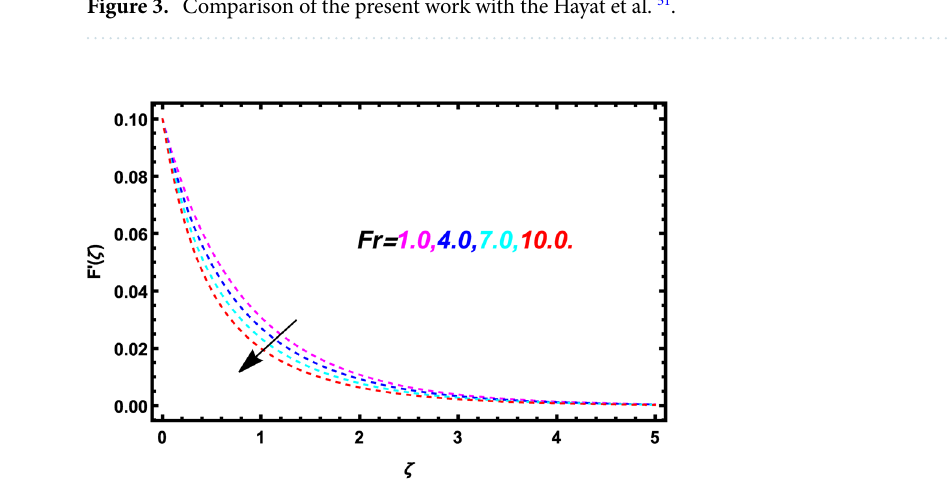
Figure 4. Demonstration of velocity curve versus Fr , when k 1 = 0.1, k 2 = 0.3, M = 0.5, m = 0.2, Pr = 5.3, φ = 0.01, Ec = 0.3, ε Rd = 0.2, Sc = 0.1, ε Lb = 0.3, Pe = t = 3.0, C = 3.0, δ = 0.3,